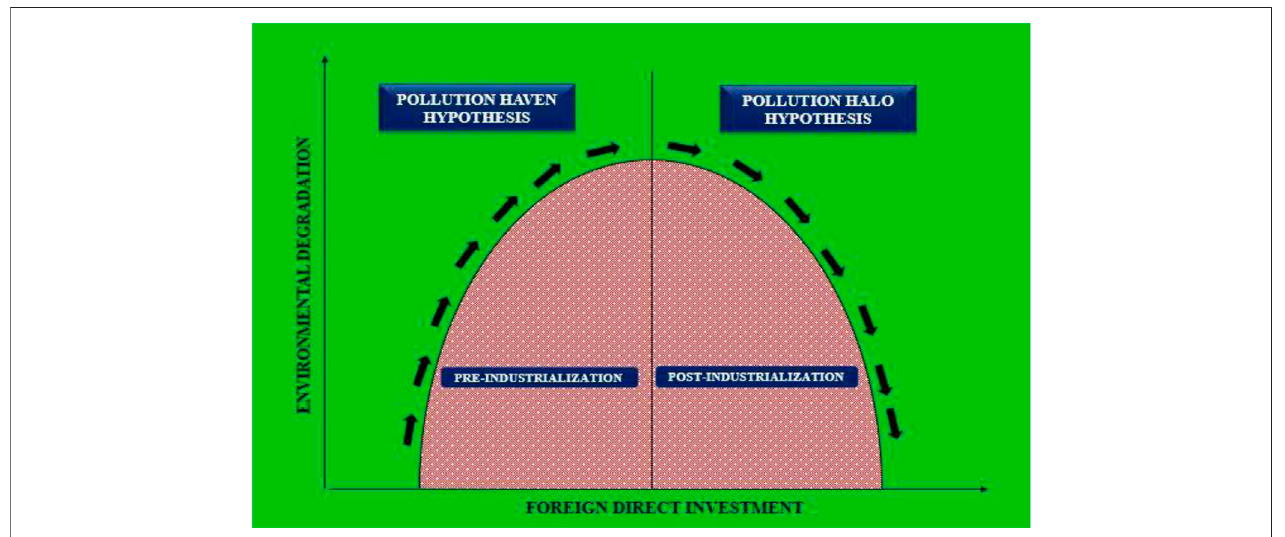
FIGURE 2 | Inverted U-shaped relationship between FDI and environmental